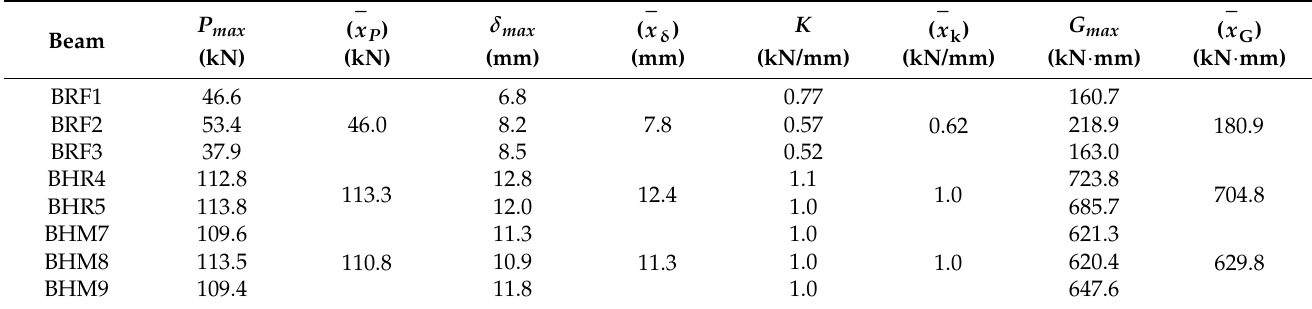
Table 6. Results obtained in the flexural strength tests.